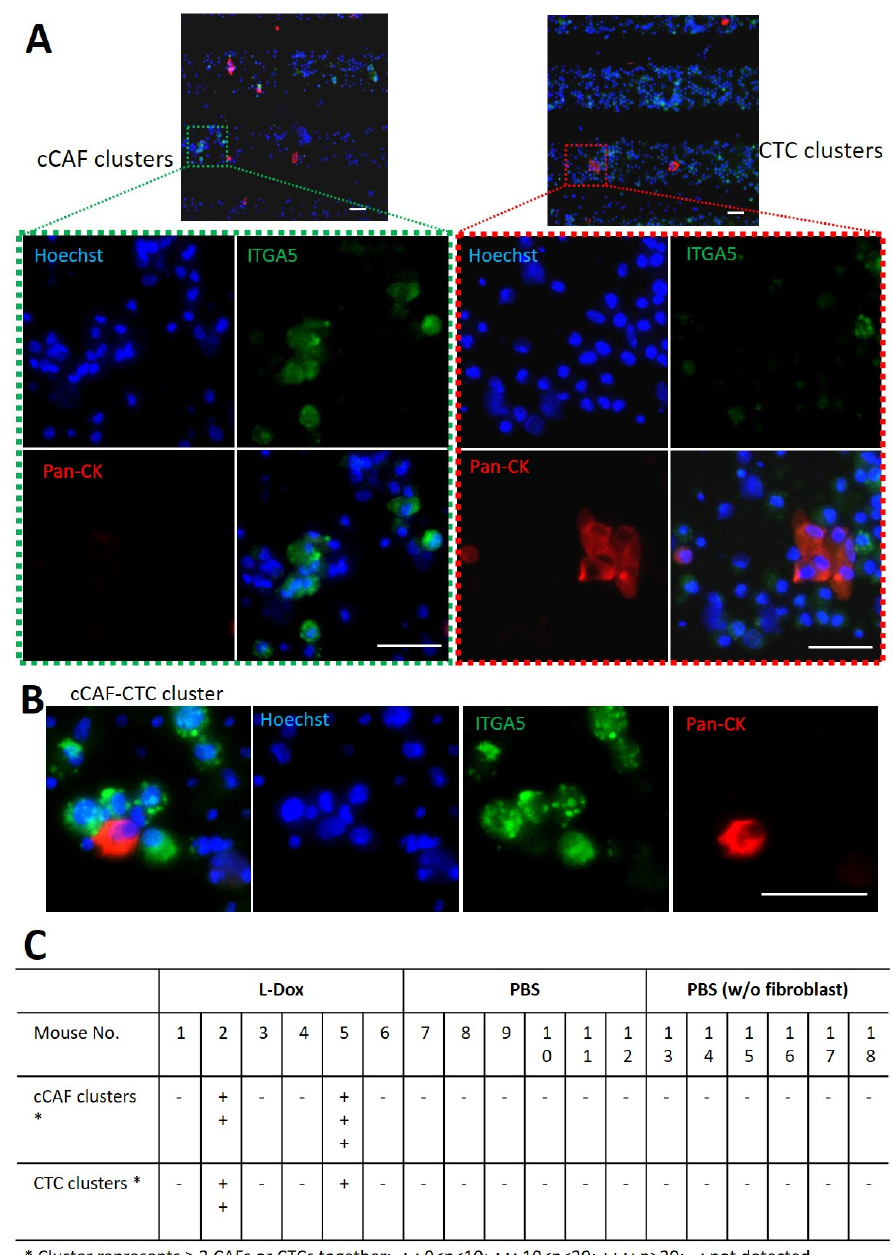
Figure 6. Clusters of CTC and cCAF detected in blood from mice with breast tumors. ( A ) Repre- sentative pictures of a cCAF cluster and a CTC cluster captured in blood. ( B ) Double-fluorescence images showing clusters of CTCs and cCAFs. ( C ) Table listing the overall clustering identification of each mouse in different treatment groups, showing that clusters of CTCs and cCAFs were detected in L-Dox-treated mice only. Scale bar, 40 µ